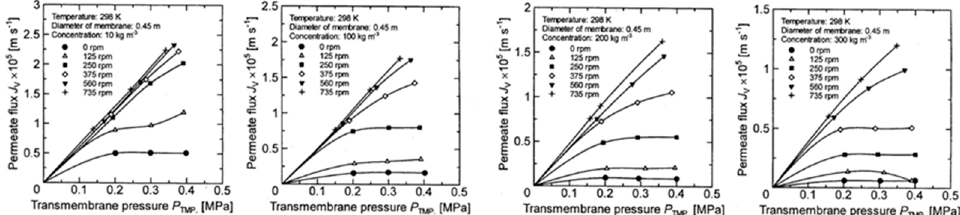
Figure 6. Relationship between measured TMP and permeate flux for disk diameter 0.45 m. ( a ) at